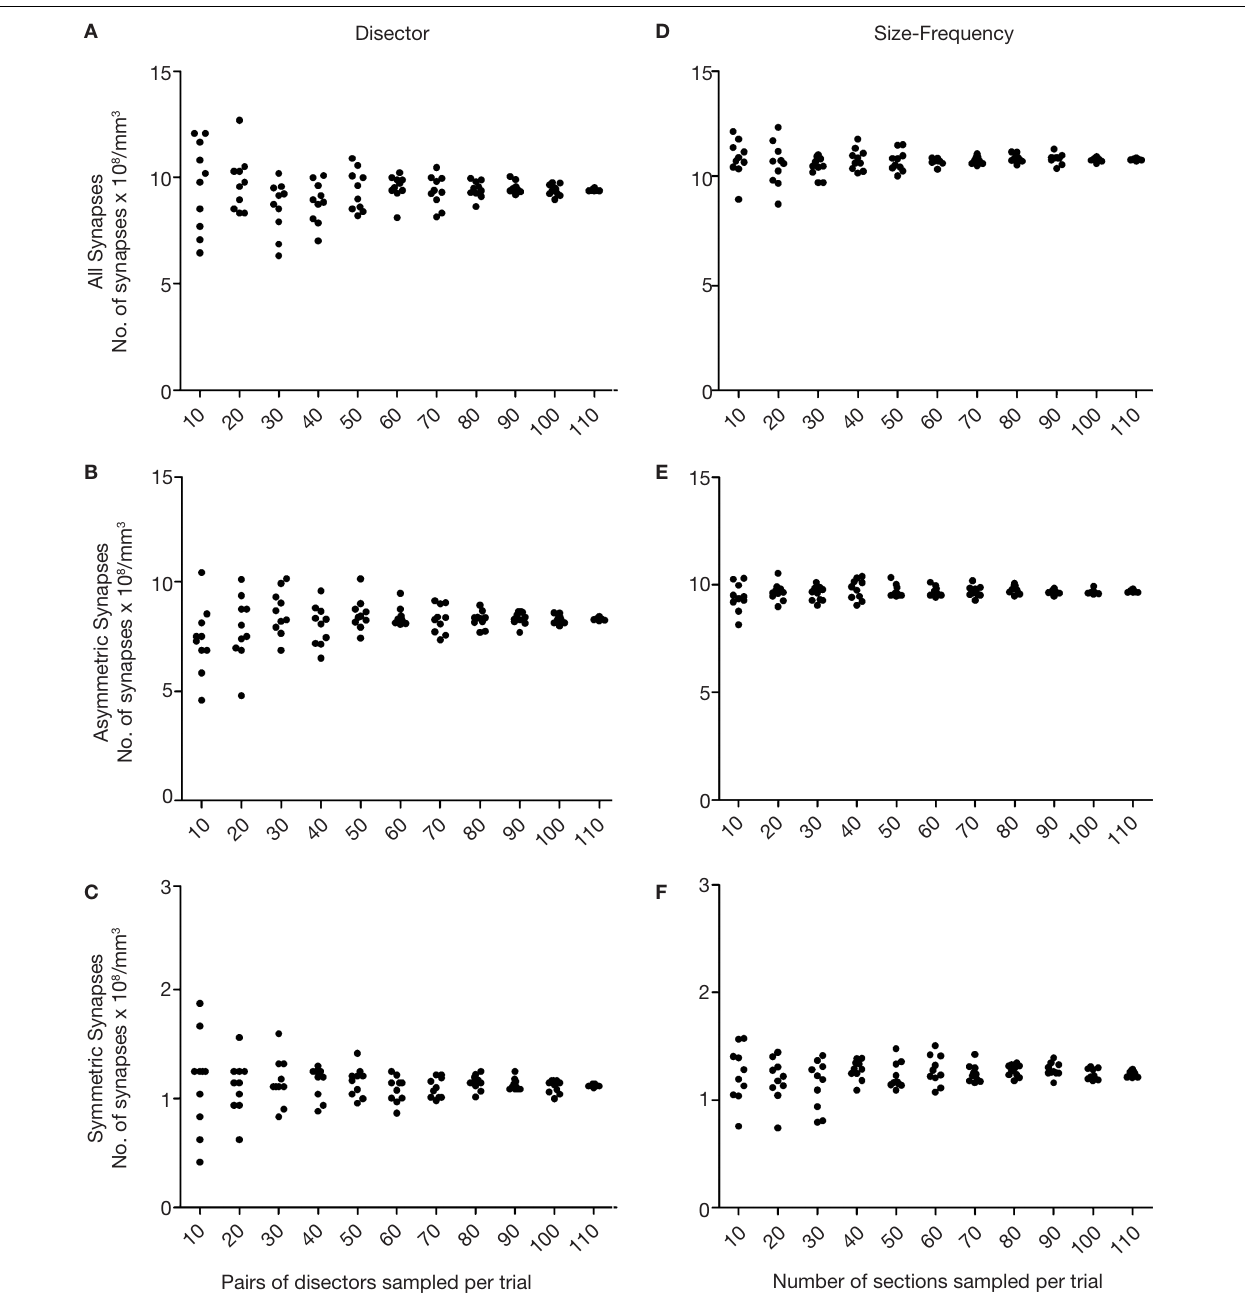
we ran 10 trials of 30 pairs of sections each, and so on until 10 trials of 110 pairs of sections had been run. As expected, the dispersion of data was less when more pairs of sections were sampled. A similar procedure was followed for the size- frequency method shown in (D) , (E) and (F) , although single sections instead of pairs of sections were used in each trial. The dispersion of the data also tended to reduce as the number of sections sampled in each trial increased. Note that the size-frequency method showed a smaller dispersion of data than the disector. Calculations for all, asymmetric and symmetric synapses were run